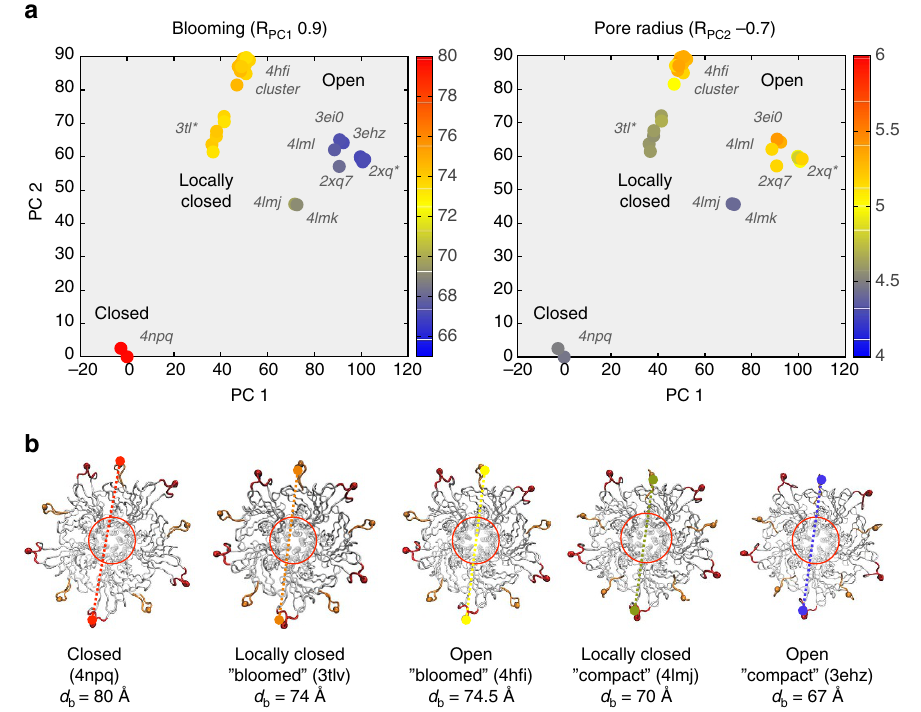
Figure 8 | Correlations between structural variables for GLIC and the PC1-2 partitions reveal two possible temperature-dependent pathways for gating. ( a ) Variation of major structural parameters in the PC1-2 subspace (Pearson Correlation in brackets; further details in Supplementary Fig. 8a). ( b ) PC1 partitions the locally closed and open structures into two subsets according to the expansion of the extracellular domain; these two subsets strongly correlate with the crystallization temperature (Supplementary Fig. 8b). Bloomed structures are solved at 290K while the more compact on the right are mainly solved at